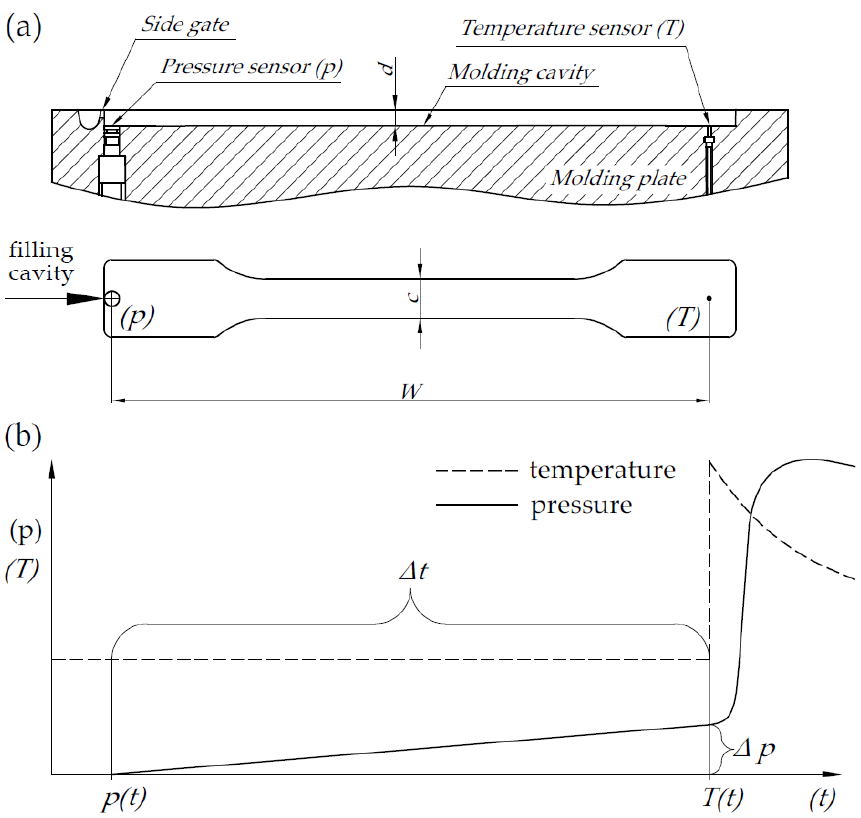
Figure 5. Method of determining the apparent viscosity during injection molding: placing of sensors in the mold cavity ( a ), changes of pressure and temperature in the mold cavity ( b ) .